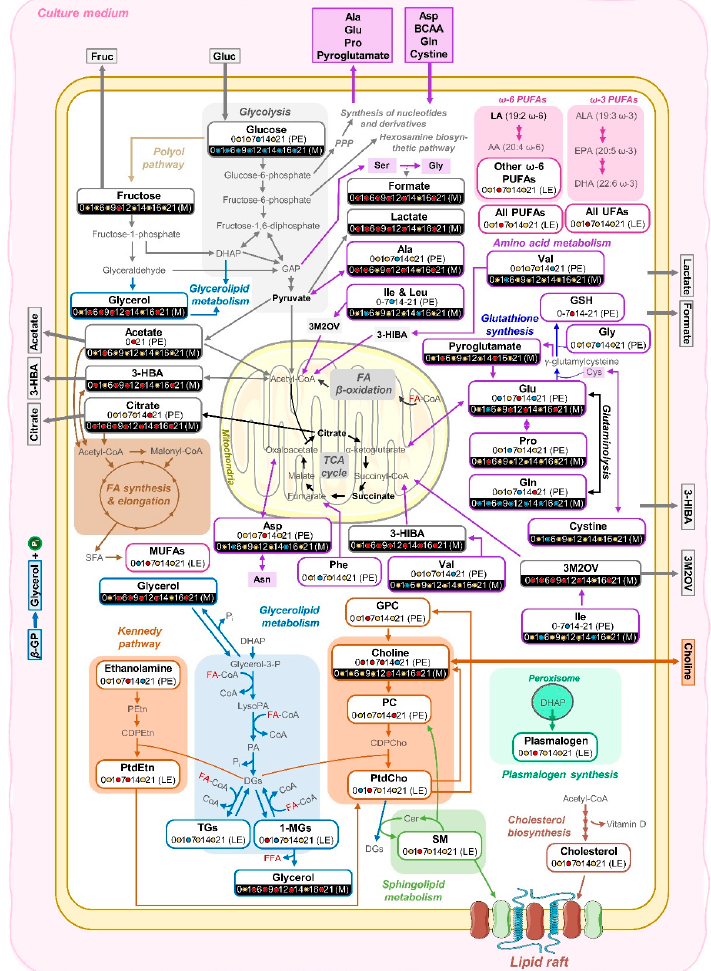
Figure 7. Schematic illustration of the main intracellular and extracellular metabolic variations detected during the osteoinduction of hAMSCs. Metabolites indicated in bold correspond to those detected by NMR. Metabolites that fluctuate over time show a schematic scale underneath (in white background for lipid and polar extracts (LE and PE, respectively), and in black background for media samples (M), where unchanged, increased, and decreased levels are shown in yellow, red, and blue circles, respectively. It should be noted that information on polar extracts refers to previously reported data [41]. Arrows crossing the cell membrane represent metabolites ex- changed between intra- and extracellular environments. Abbreviations: 3-letter code used for amino acids; 1-MG, 1-monoacylgliceride; 3-HBA, 3-hydroxybutyrate; 3-HIBA, 3-hydroxyisobutyrate; β -GP, β -glycerophosphate; AA, arachidonic acid; ALA, linolenic acid; BCAA, branched chain amino acids; CDPCho, Cytidine diphosphocholine; CDPEtn, cytidine diphosphoethanolamine; Cer, ceramide; CoA, coenzyme A; DGs, diacylglicerides; DHA, docosahexaenoic acid; DHAP, dihydroxyacetone phosphate; EChol, esterified cholesterol; EPA, eicosapentaenoic acid; FA-CoA, fatty acyl coenzyme A; FAs, fatty acids; FChol, free cholesterol; FFAs, free fatty acids; Glycerol-3-P, glycerol-3-phosphate; GPC, glycerophosphocholine; GSH, glutathione (reduced); LA, linoleic acid; LysoPA, lysophospha- tidic acid; MUFAs, monounsaturated fatty acids; PA, phosphatidic acid; PC, phosphocholine; PEtn, phosphoethanolamine; PPP, pentose phosphate pathway; PtdCho, phosphatidylcholine; PtdEtn, phosphatidylethanolamine; PUFAs, polyunsaturated fatty acids; SFA, saturated fatty acis; SM, sphin- gomyelin; TCA, tricarboxylic acid; TGs, triacylglyceride; and UFA, unsaturated fatty acids. Some elements were adapted from Servier Medical Art and licensed under a Creative Commons Attribution 3.0 Unported (CC BY 3.0)